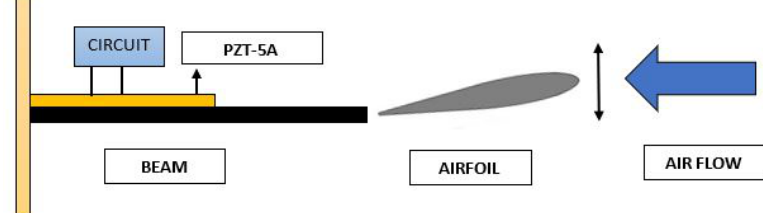
Figure 7. Flutter-based piezoaeroelastic energy harvester schematic.